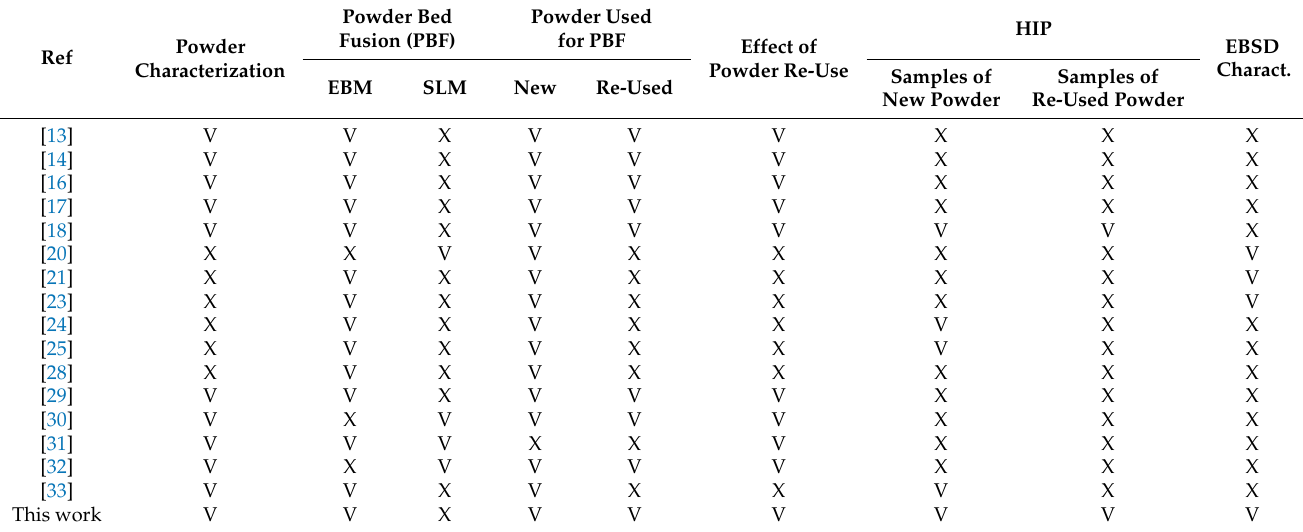
Table 1. Selected recent publications on the same topic in comparison with the current review.